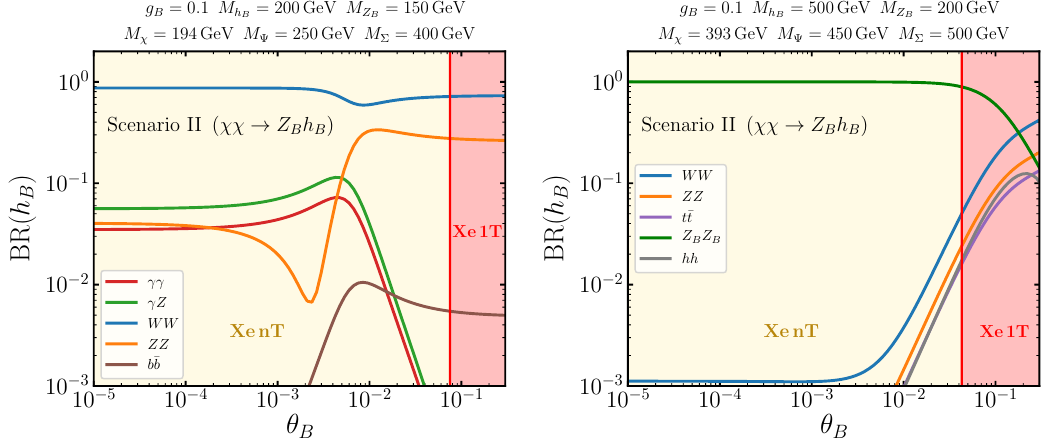
Figure 5 . Branching ratios of the Baryonic Higgs h B as a function of the scalar mixing angle θ B in the context of Scenario II, where χχ → Z B h B is the dominant annihilation channel. The relevant parameters have been fixed as indicated in the plot to satisfy the dark matter relic density Ω h 2 = 0 . 12 . The different colors correspond to different decay channels as shown in the plot. The area shaded in red is ruled out by Xenon-1T direct detection constraints, while in yellow we show the region that will be probed by